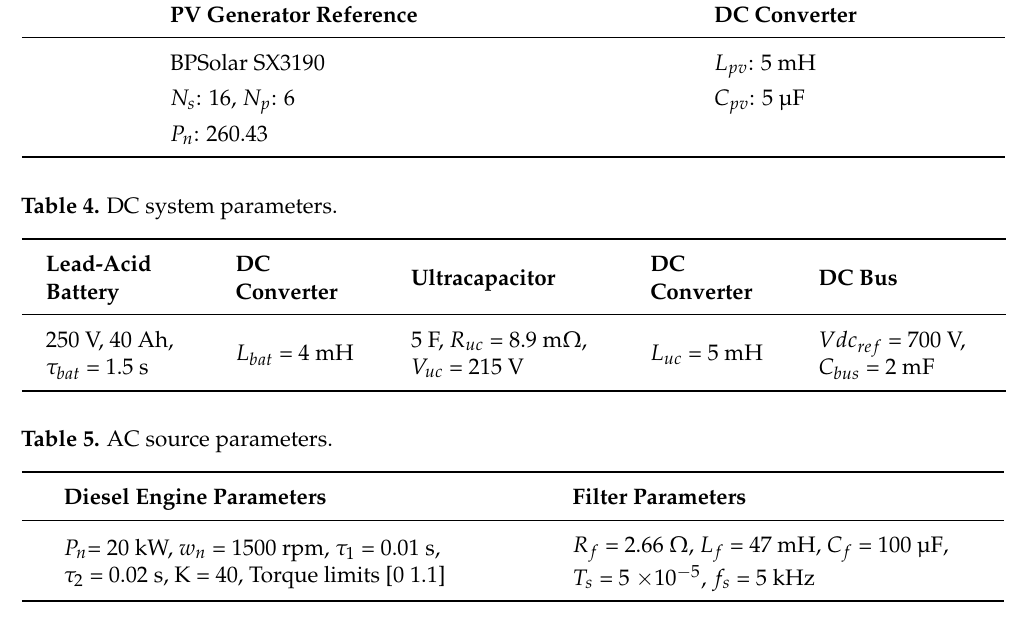
Table 6. Connection mode control parameters.